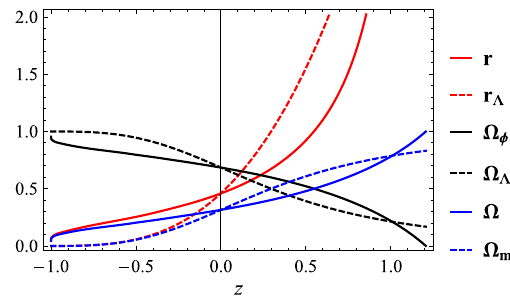
Fig. 6 Evolution of (122) in terms of redshift, which give the asymp- totic values of the ratio r and Ω φ , Ω m under the interacting scheme (117) with Q = − 3 (δ 2 + 1 ) ln ( 1 + z ) . The exact solutions for the Λ CDM model are superimposed (dashed lines) for a